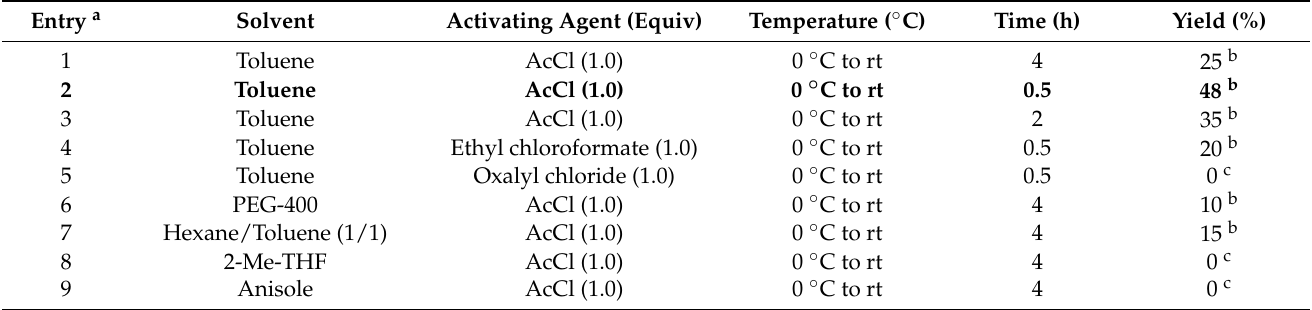
Table 2. Optimization of the C-H/C-H coupling reaction of 4 H -imidazole 3-oxide 3a with indole 4a (bold for the best result of optimization) .